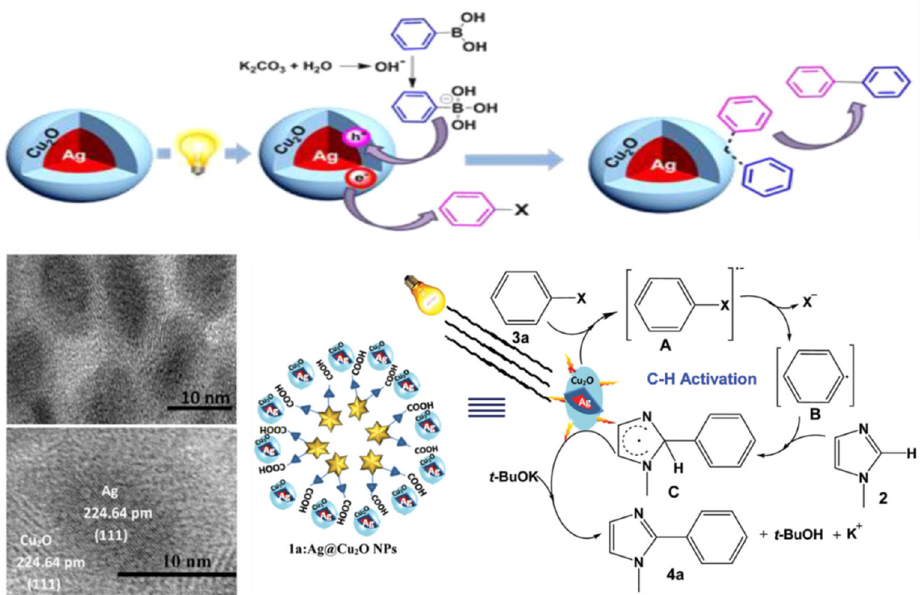
Figure 14. Ag@Cu 2 O core–shell nanoparticles (NPs) stabilized by a supramolecular ensemble for photocatalytic Suzuki coupling. Reproduced with permission from References [134,135]. Copyright 2015 and 2016 Royal Society of Chemistry.